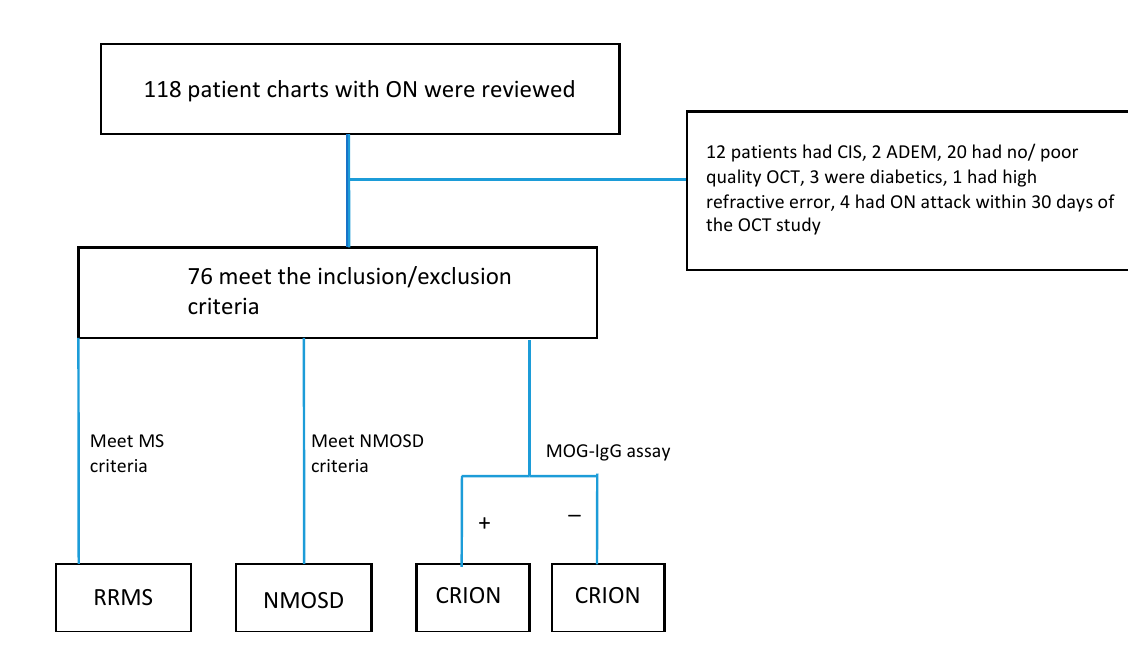
Figure 1. The flow chart depicts the steps of our study, from record identification to patient eligibility. It maps out the total number of records identified, the number of excluded cases and the reasons for exclusions, and the final number of eligible participants from each group. CIS: clinically isolated syndrome, ADEM: acute disseminated encephalomyelitis, RRMS: relapsing-remitting multiple sclerosis, CRION: chronic recurrent inflammatory optic neuropathy.